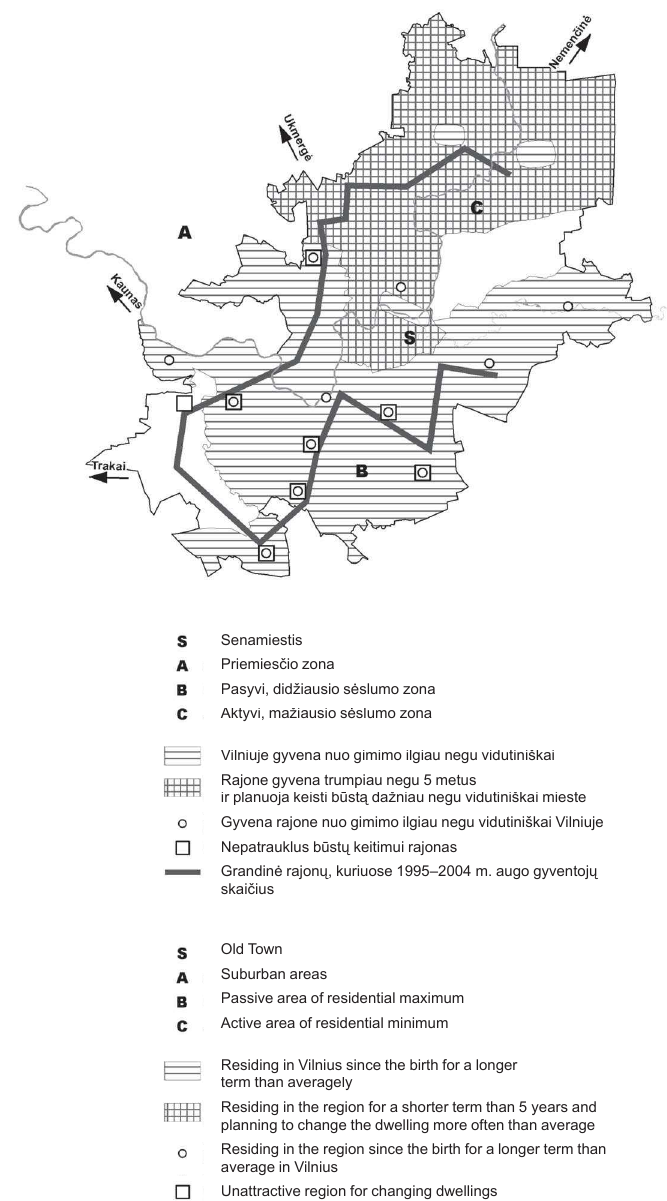
Senamiestis Priemiesčio